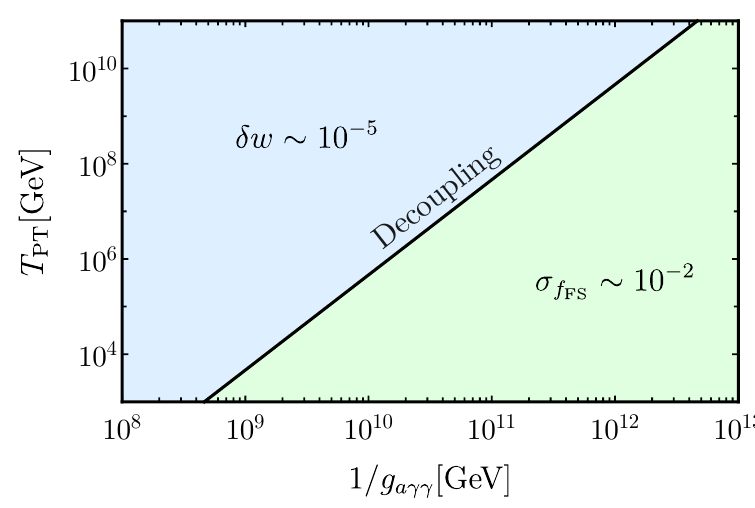
Figure 7 . The region of axion parameter space that can be probed as a deviation from the equation of state or as a free streaming fraction. The black line, T dec ( g aγγ ) , gives the decoupling temperature of the axion as a function of the coupling to photons. In the blue region, axions in equilibrium with the SM predict δw ∼ 10 − 5 while in the green region, free streaming axions predict f FS ∼ 10 − 2 so long as the reheating temperature, T RH , satisfies T RH > T dec ( g aγγ )